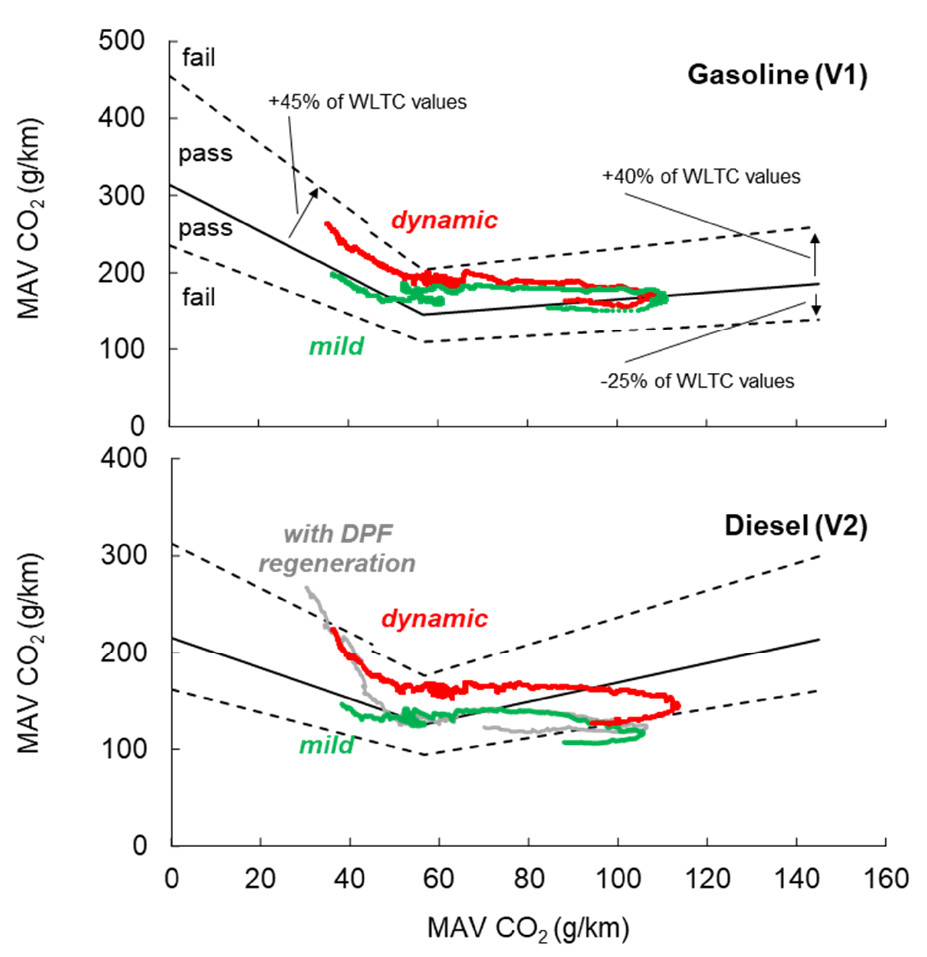
Figure 6. Influences of the driving style on CO 2 emissions for normality check for vehicle 1, gasoline, and vehicle 2,